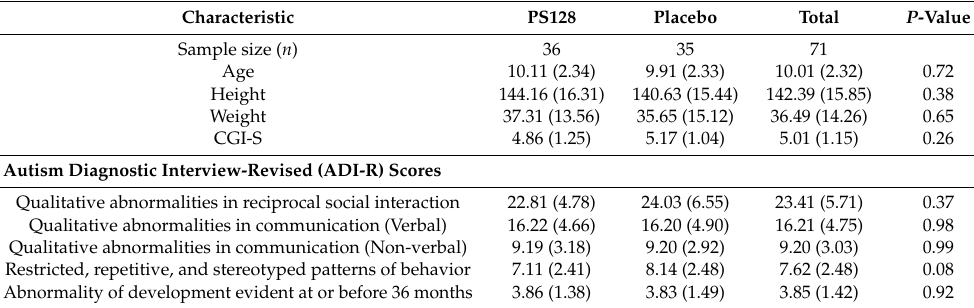
Table 1. Demographic and clinical characteristics of the subjects at baseline.